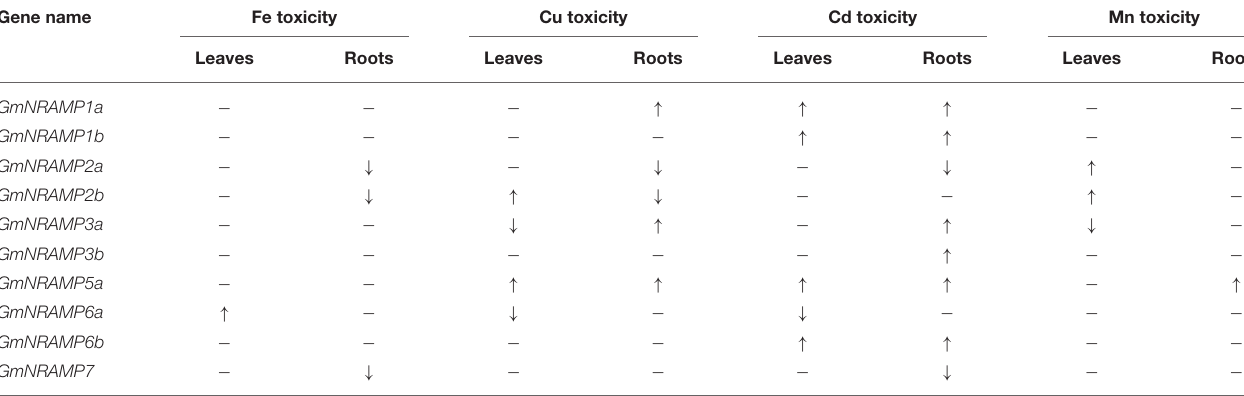
TABLE 3 | Summary of the response of soybean NRAMP genes to different divalent metal